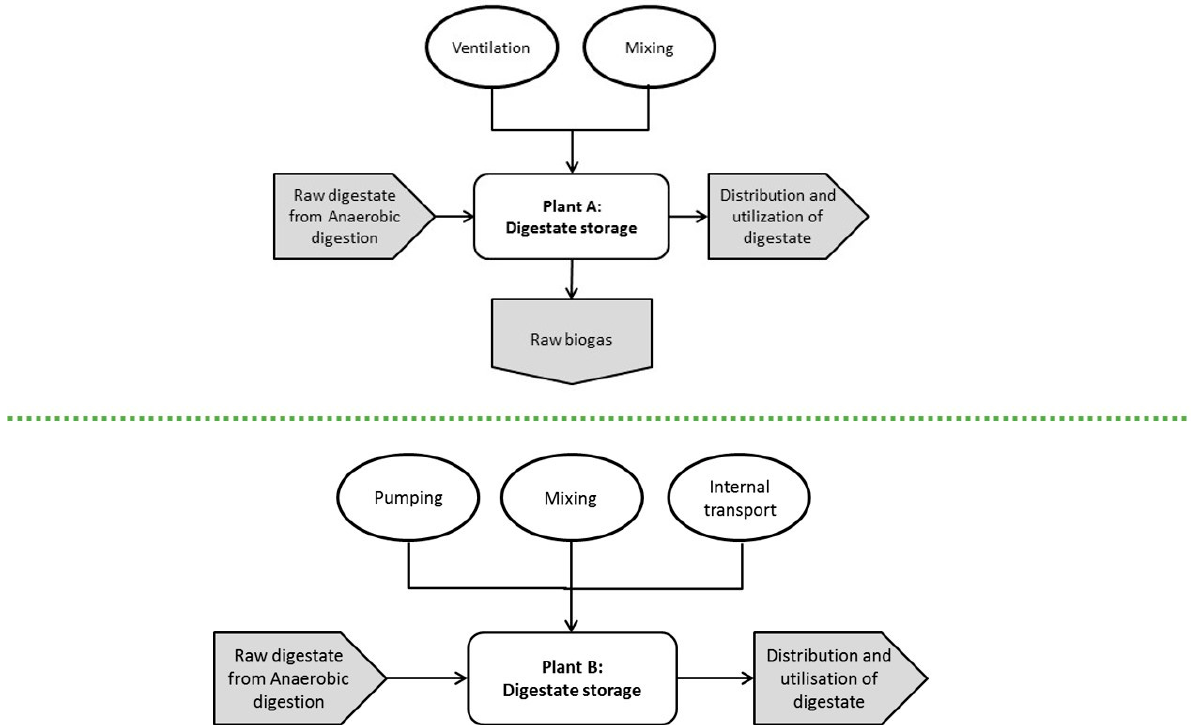
Figure 7. The connection between the sub-process digestate storage and unit processes at biogas plant A and B, respectively.